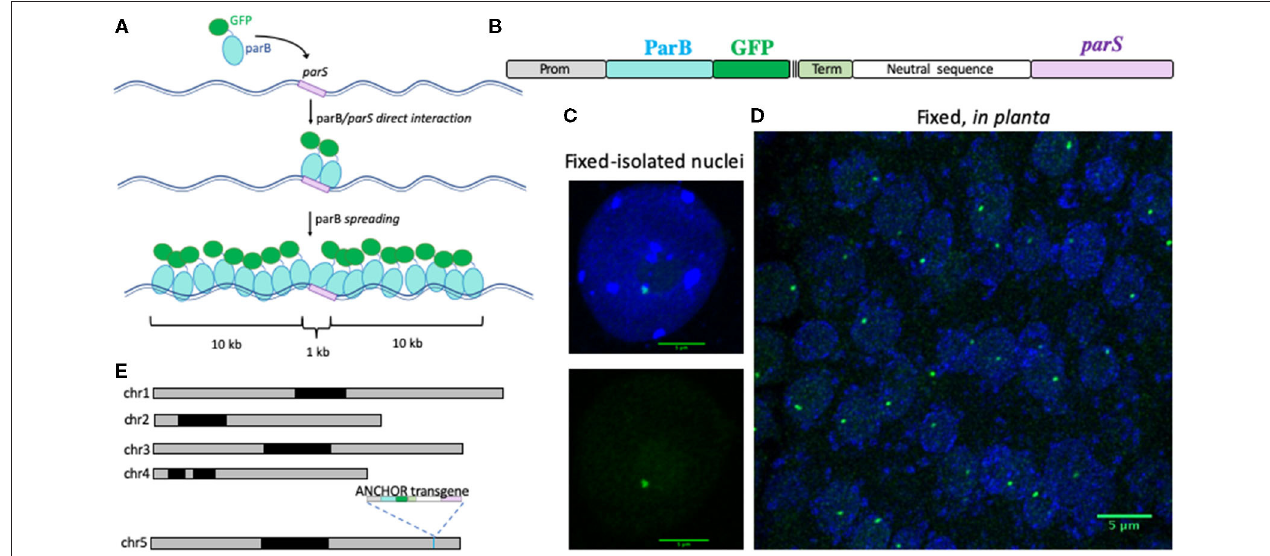
FIGURE 1 | Description of the ANCHOR system in planta. (A) Schematic representation of the ANCHOR system. ParB proteins fused to GFP can directly bind to parS sequence as a dimer. parS -ParB interactions provoke a conformational change in ParB proteins that induce their oligomerization along the flanking genomic region. (B) Cassette used to transform Arabidopsis thaliana Col-0 plants to test the ANCHOR system in planta. A strong and ubiquitous promoter is used to express the ParB protein fused to GFP and three FLAG tags. After a terminator sequence, a 1.5 kb-long spacer sequence has been added to separate the ParB:GFP open reading frame and the 1 kb-long parS sequence. Detection of a parS -ParB:GFP focus (green) in an isolated leaf nucleus (C) and in fixed root tissues (D) of A. thaliana plants containing the ANCHOR cassette described in (B) . Nuclear DNA is labeled with DAPI (blue). Bar = 5 µ m. (E) Position of the transgene in the ANCHOR line T2F in the Arabidopsis genome using nanopore sequencing. The transgene presented in (B) is inserted on chromosome 5, position 23.675.998